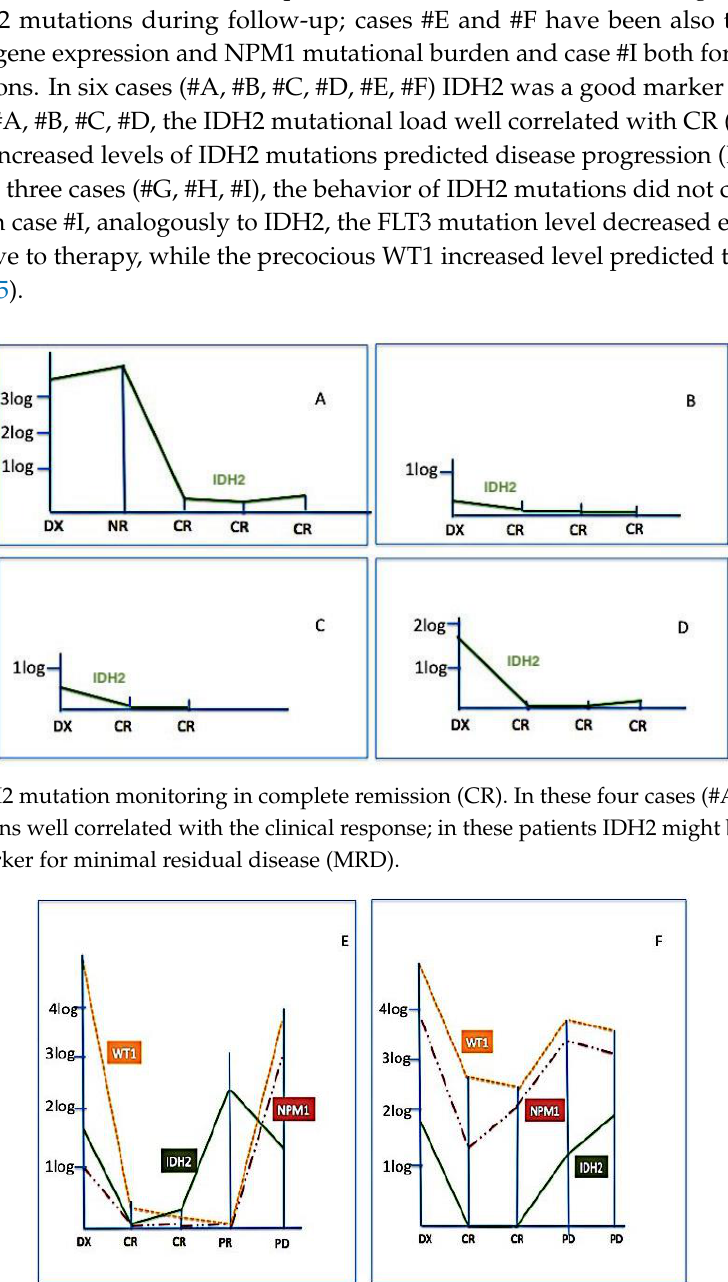
Figure 4. IDH2 mutation monitoring in disease progression (PD). These represent two cases (#E and #F) where MRD has been monitored by Wilms’ tumour 1 (WT1) gene expression (orange line), Nucleophosmin 1 (NPM1) mutational burden (red line), and IDH2 (green line). In both cases, all three markers (IDH2 = green line) presented the same trend, predicting the loss of response. Moreover, in these patients, IDH2 might be considered as a good marker for MRD.